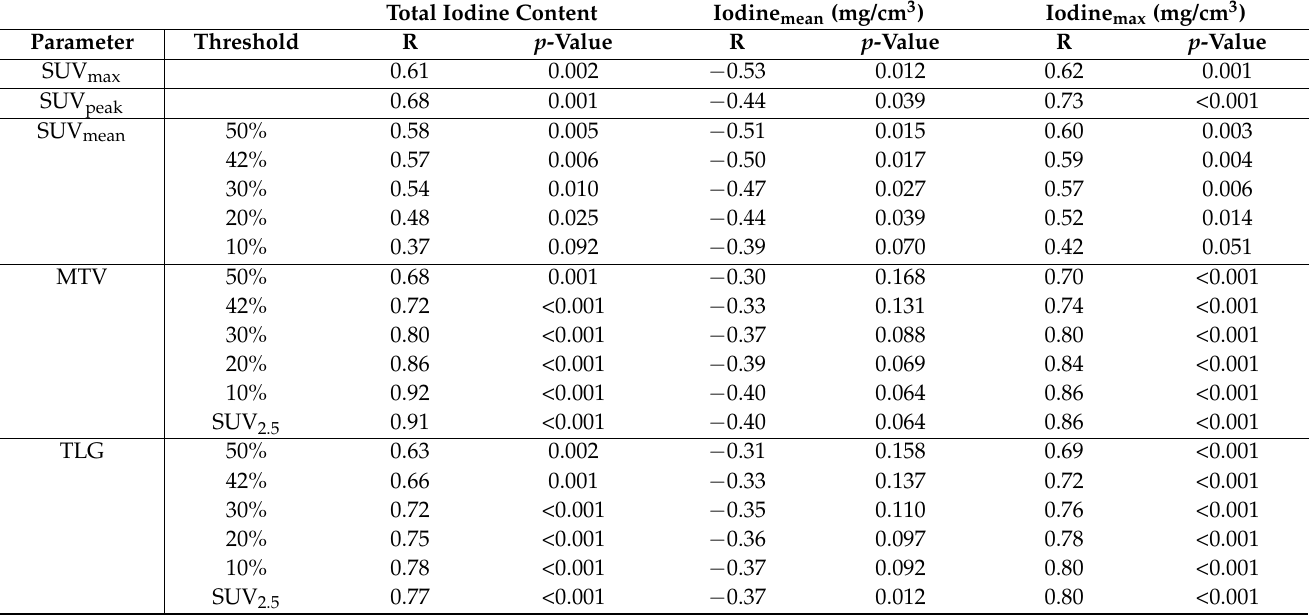
Table 2. A summary of Pearson correlations of FDG uptake and iodine-related parameters at different thresholds of metabolic values with accompanying p -values. SUV: standard uptake value; MTV: metabolic tumor volume; TLG: total lesion glycolysis; r: Pearson correlation coefficient. All parameters that are related to volume (MTV; TLG; total iodine content) were log 10 -transformed to achieve normal distribution before calculating the correlation coefficient.